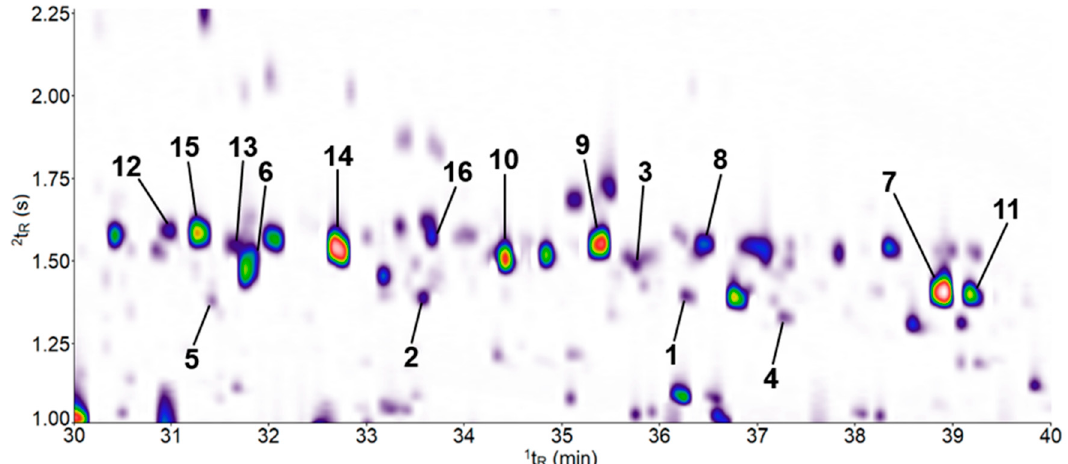
Figure 7. Contour plot of a headspace solid-phase microextraction (HS-SPME)–gas chromatography (GC)×GC–time-of-flight mass spectrometer (TOF–MS) chromatogram (TIC) demonstrating the separation of sesquiterpenes isolated from the headspace of a 30-day-old Arabidopsis thaliana plant grown on nootkatone-containing Knop agar. The 1 tR (X-axis) corresponds to the retention time on the first dimension ( 1 D) column and 2 tR (Y-axis) to the retention time on the secondary ( 2 D) column. The color gradient reflects the intensity of the TOF-MS signal on white background from low (violet) to high (red). Numbers at peaks refer to compound numbers, as defined in Table 1 and Figure S2. The 3D view of the chromatogram section shown can be found in Supplementary Figure S3. Table 1. Sesquiterpene hydrocarbons identified in the headspace of 30-day-old Arabidopsis thaliana .